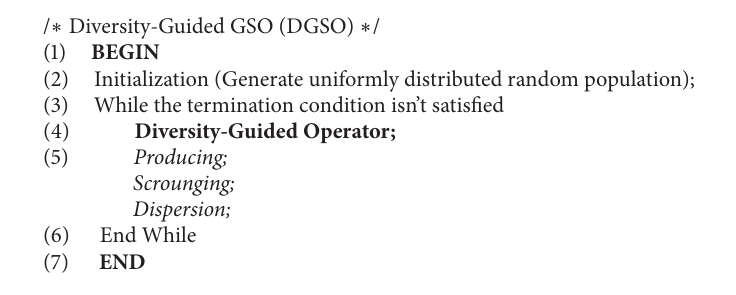
Algorithm 1: Procedure of diversity-guided GSO (DGSO).